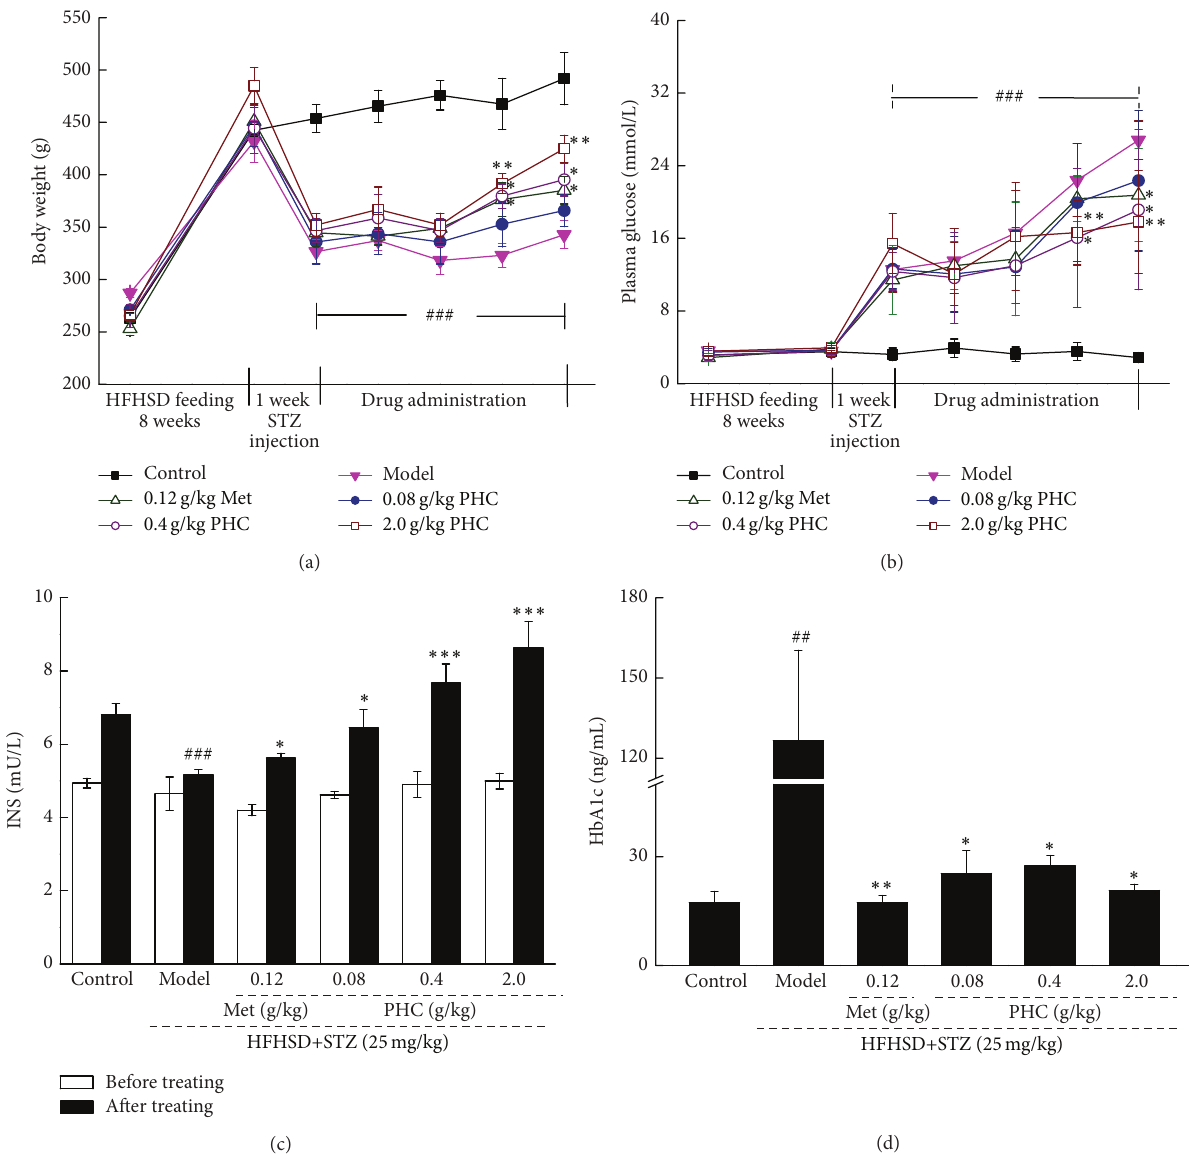
Figure 1: Diet-STZ-induced diabetic rats were treated with or without 0.12 g/kg metformin (Met) and Paecilomyces hepiali water extract (PHC)atindicateddosesforfourweeks.Thechangesonbodyweight(a)andfastingplasmaglucoselevel(b)weremonitoredduringthewhole drug administration period. After the final drug treatment, the serum levels of insulin (c) and glycosylated hemoglobin (d) were detected in all experimental rats. Data are expressed as mean ± SD ( 𝑛 = 10 ) and analyzed by using one-way ANOVA. ## 𝑃 < 0.01 and ### 𝑃 < 0.001 versus normal controls, ∗ 𝑃 < 0.05 , ∗∗ 𝑃 < 0.01 , and ∗∗∗ 𝑃 < 0.001 versus nontreated diabetic rats.